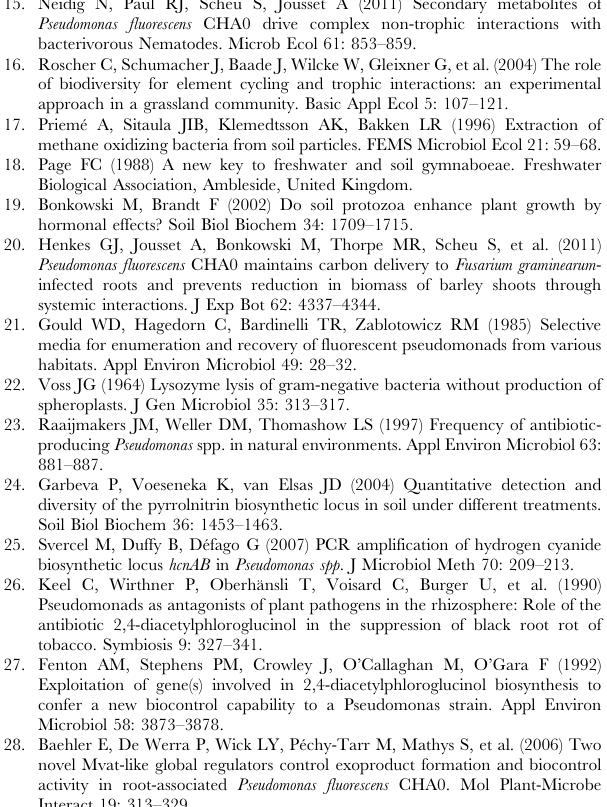
suppression and may be used to develop new biocontrol inocula with high persistence in soils. Table S1 Abundance of cultivable bacteria and pseudo- monads at the different time points after incubation with or without Acanthamoeba castellanii . Bacteria were enumerated on TSA (total heterotrophic bacteria) or Gould S1 (Pseudomonas), abundances are expressed as CFU per plants.